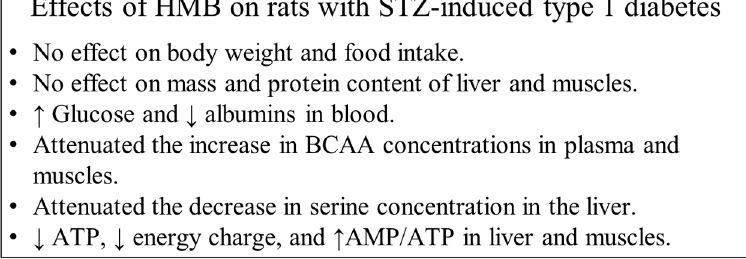
Figure 4. E ff ects of HMB in rats with STZ-induced type 1 diabetes Figure 4. Effects of HMB in rats with STZ-induced type 1 diabetes mellitus.